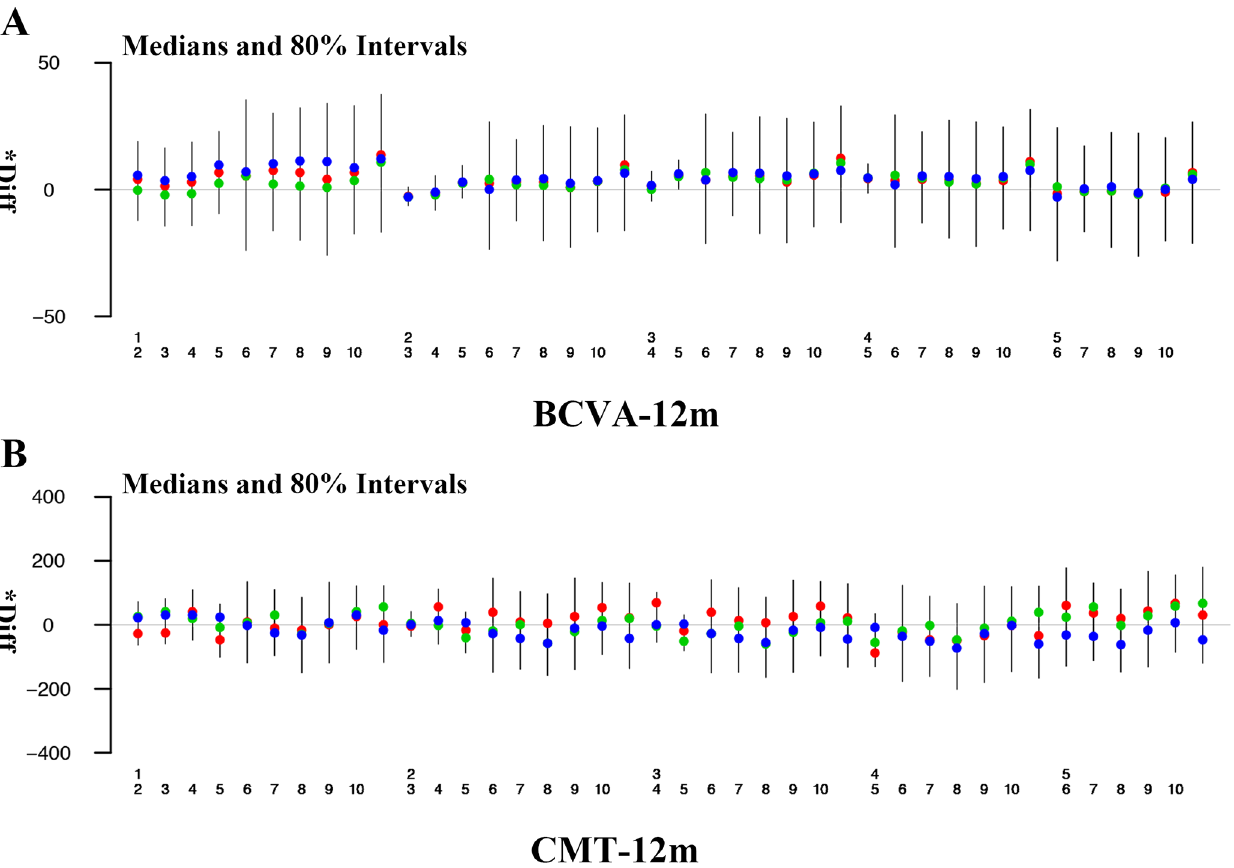
Fig 5. Forest plots for BCVA and CMT in 12 months. Abbreviations: 1, IVA; 2, IVB; 3, IVR; 4, IVR+LASER; 5, LASER; 6, DDSI; 7, IVB+IVT; 8, DDSI+LASER; 9, IVB+LASER; 10, IVT+LASER; 11, Placebo.